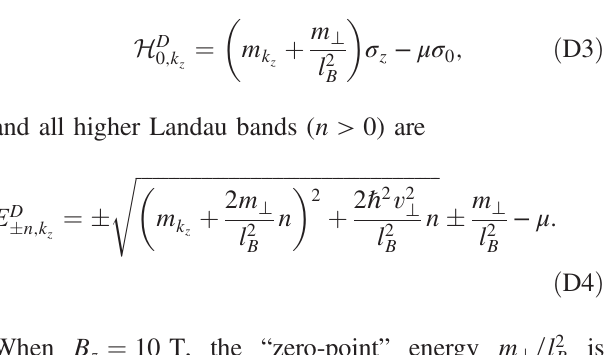
FIG. 5. Evolution of Landau bands of Kramers-Weyl semimetal. (a) Only Landau level effect, (b) Zeeman effect δ chiral coupling term (SOC) v ⊥ k ⊥ · σ ⊥ considered, and (d) additional rotation symmetry breaking term δ